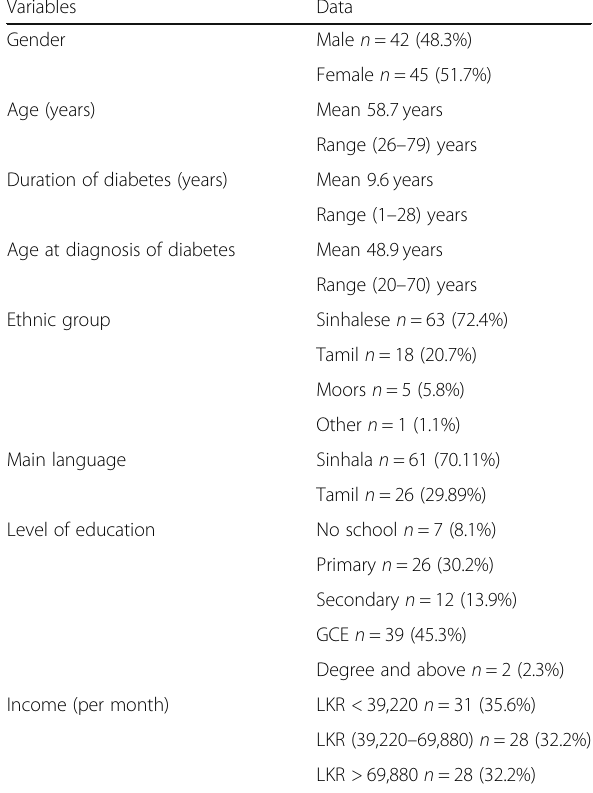
Table 2 Participants ’